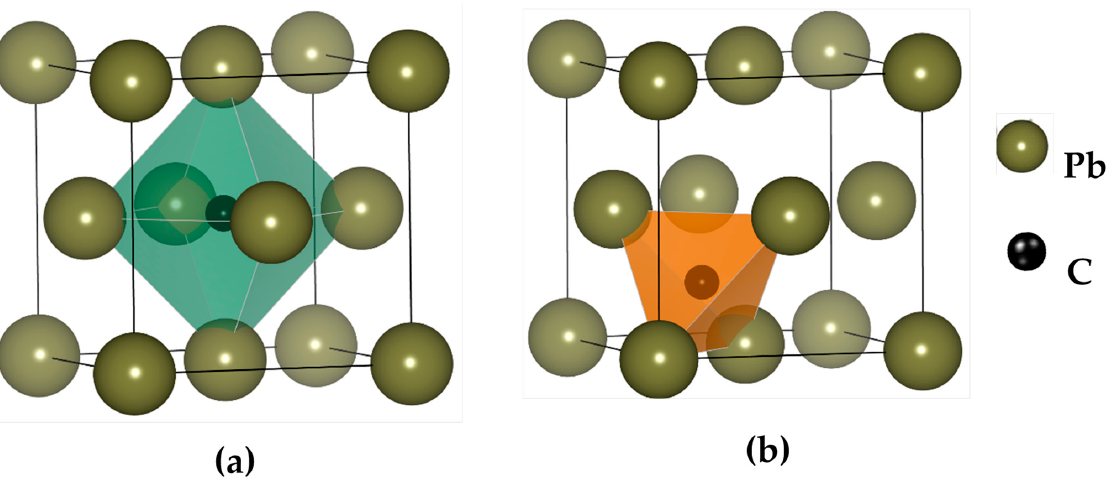
Figure 2. Schematic of a unit cell of Pb (FCC) showing C at ( a ) an octahedral interstitial site, and ( b ) a tetrahedral interstitial site.